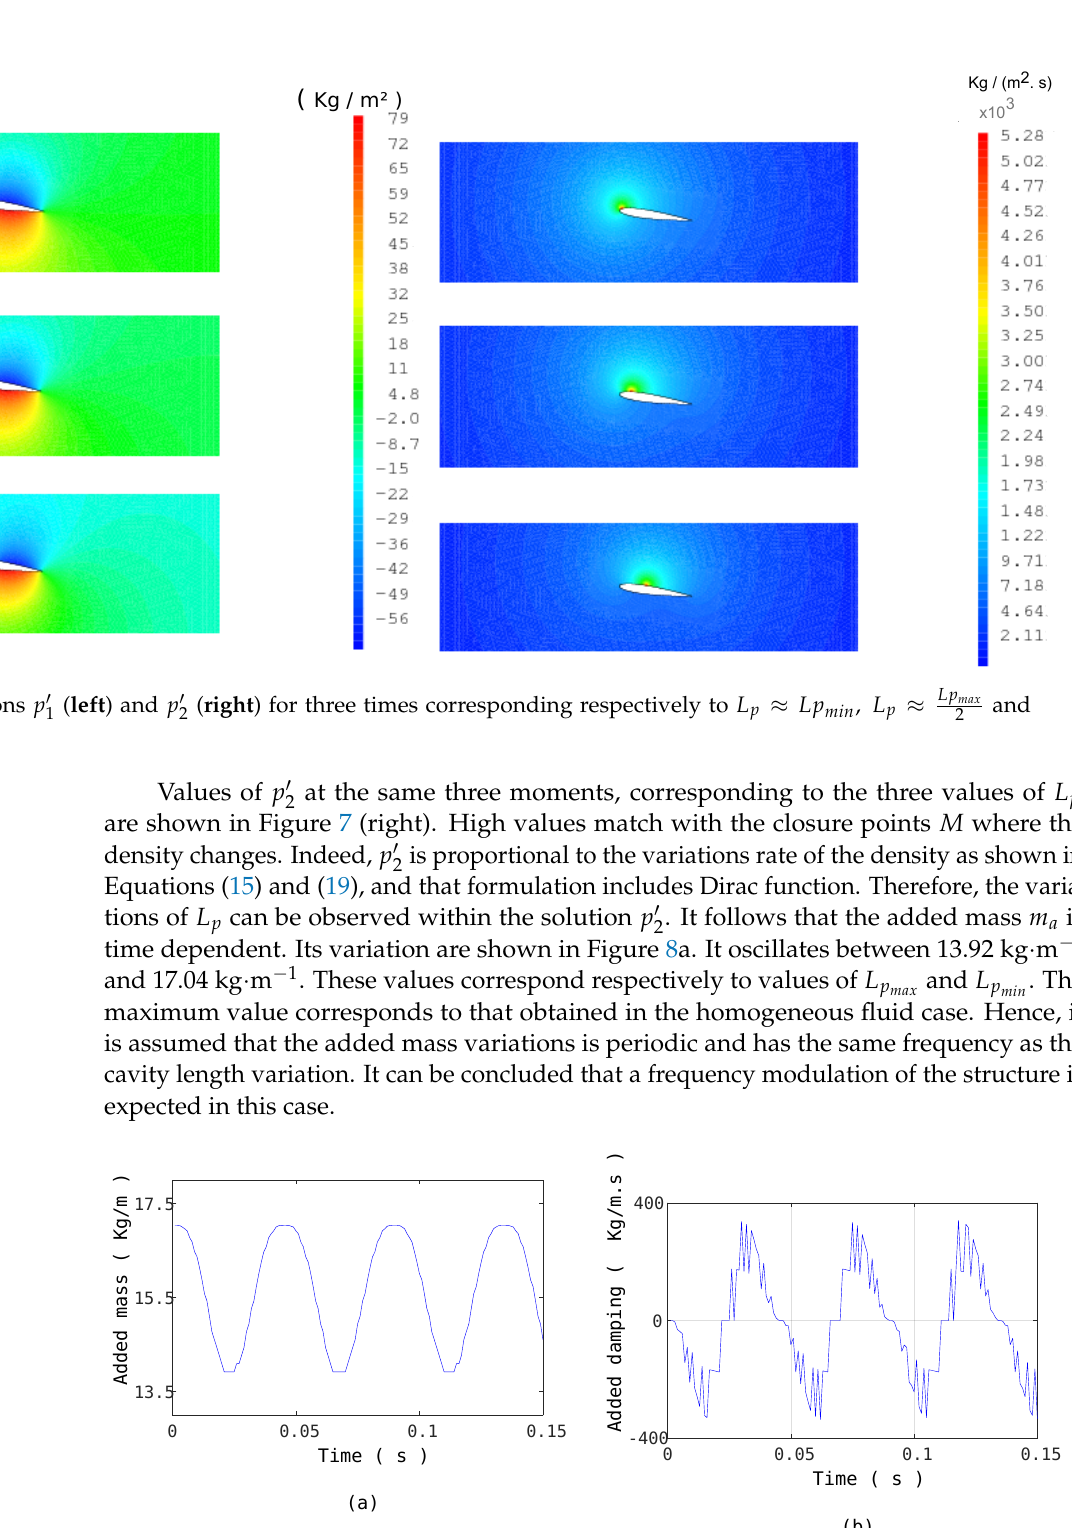
Figure 8. ( a ) Added mass variation versus time. ( b ) Added damping variation versus